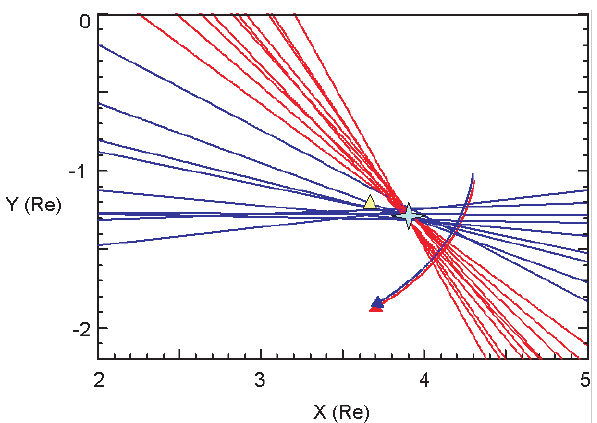
Fig. 3. Triangulation in XY GSE plane. Directivity lines drawn from C4 in the Southern Hemisphere (blue lines) and from C2 in the Northern Hemisphere (red lines) for the 70-kHz emission indicate a source (grey star) further from the Earth than the source position estimated according to the radio window beaming theory (yellow triangle). The arrows give the trajectories of C2 and C4.